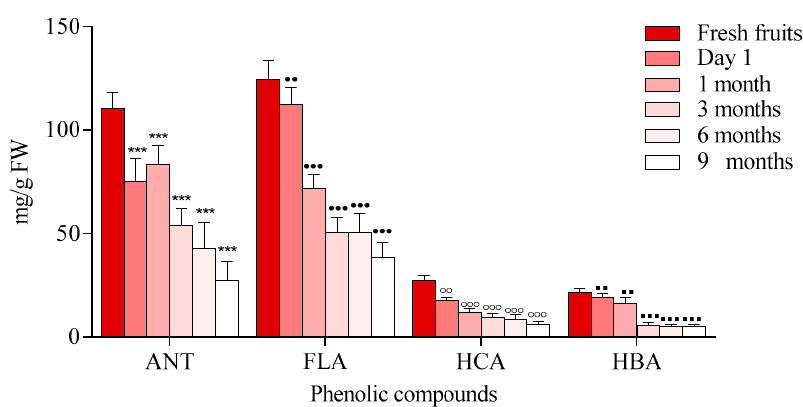
Figure 3. Phenolic compound degradation of chokeberry jams during storage, (anthocyanins (ANT), flavonols (FLA), (hydroxycinnamic acids (HCA) hydroxybenzoic acids (HBA)) Data represents the means ± SEM of at least three independent experiments (significant differences, ** , ●● , ◦◦ , ▪▪ p < 0.01, *** , ●●● , ◦◦◦ , ▪▪▪ p < 0.001).